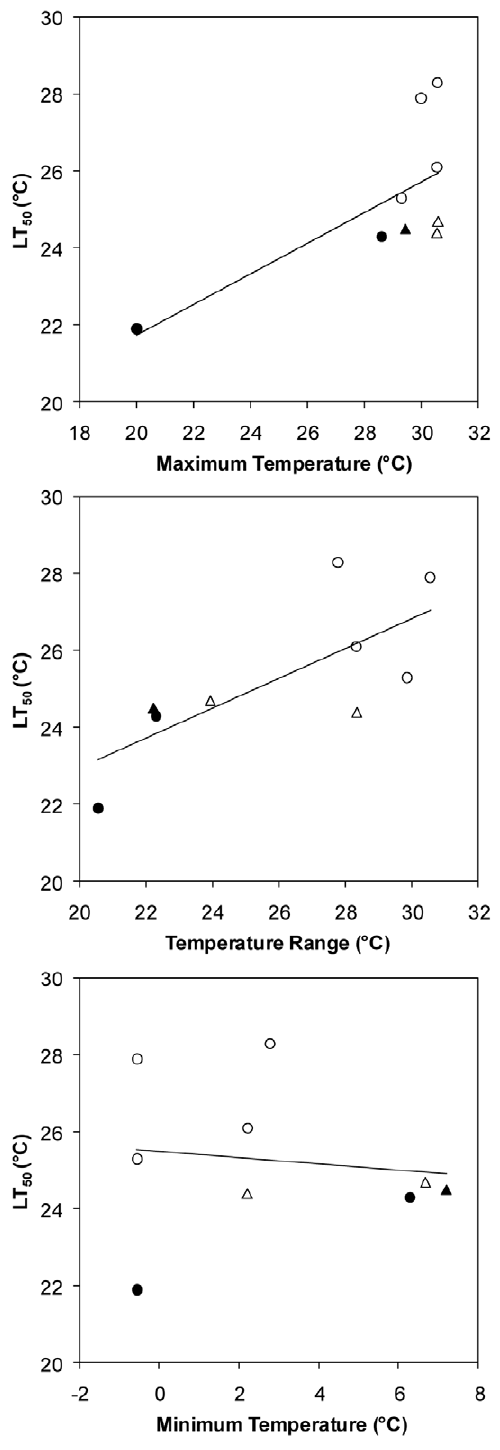
Figure 2. Relationship between lethal temperature tolerance and geographic temperature attributes. Each datapoint repre- sents one of the 9 study species, including 3 natives (closed symbols) and 6 invasives (open symbols) within 2 phyla: tunicates (circles) and bryozoans (triangles). Higher LT 50 values were associated with higher maximum temperatures (linear regression, p =0.039) and broader geographic temperature ranges ( p =0.022), calculated by subtracting the minimum monthly mean temperature from the maximum monthly mean temperature across the species’ ranges (see Table 1 and Materials and Methods), but were not related to minimum temperatures.